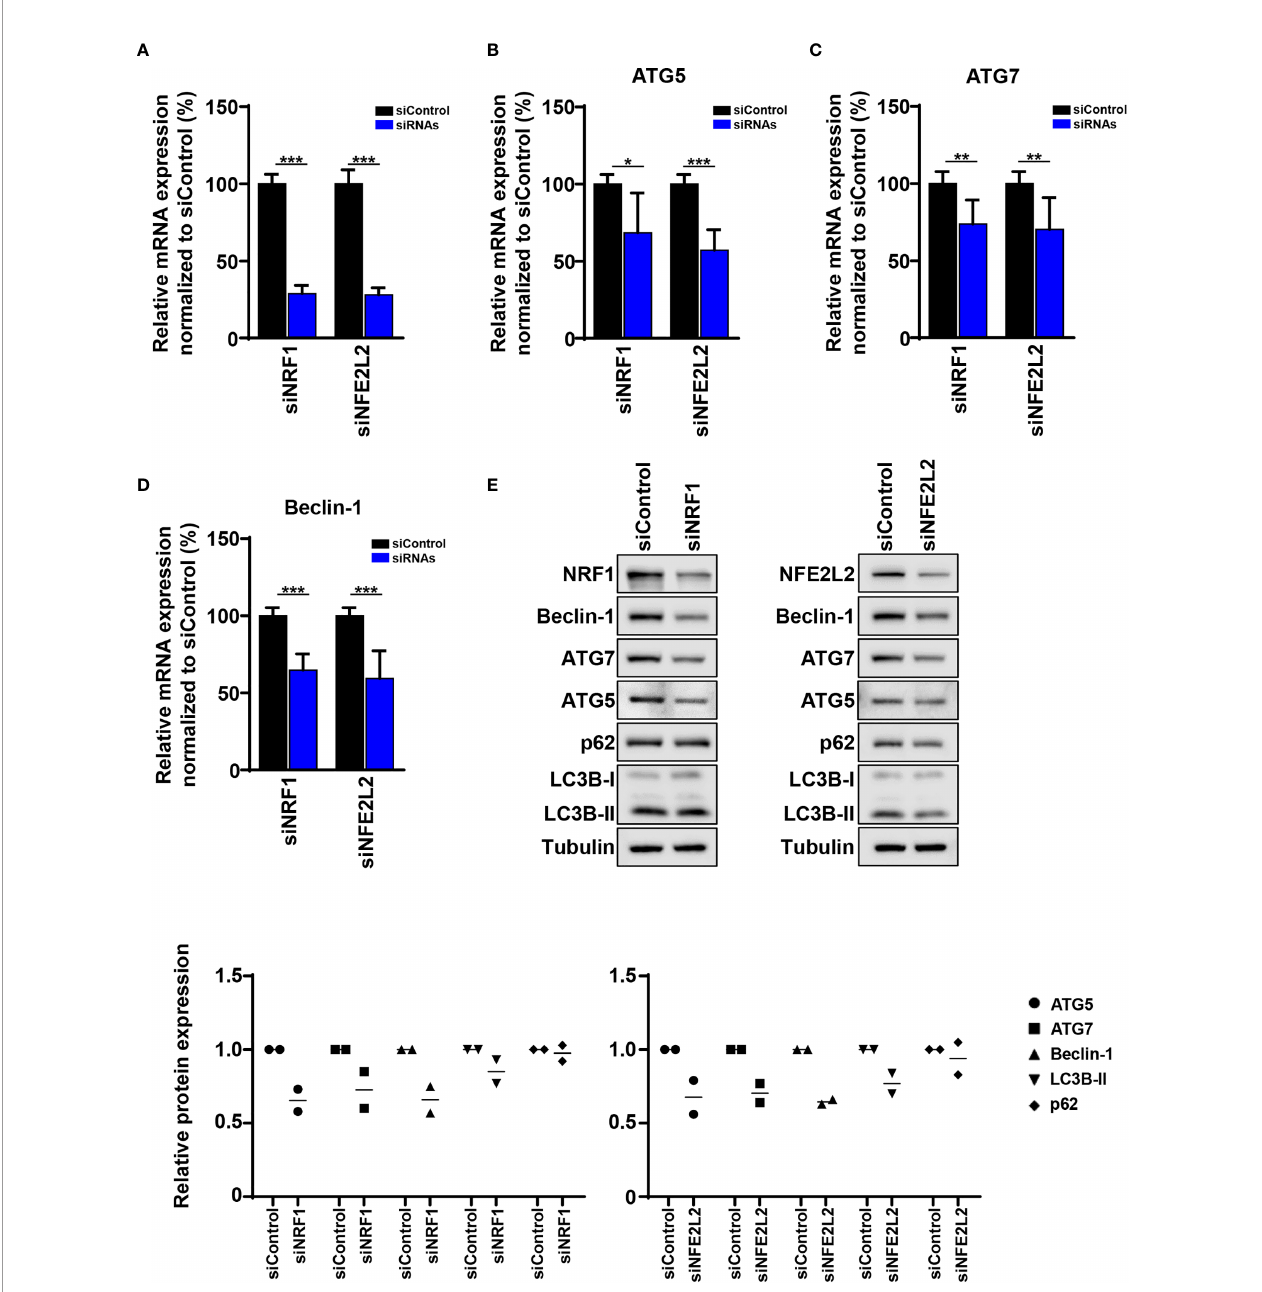
FIGURE 5 | The mRNA and protein levels of ATG5, ATG7, and Beclin-1 are in fl uenced by siRNA knockdown of NRF1 and NFE2L2 . (A) Quantitative polymerase chain reaction (qPCR). SK-MEL-5 melanoma cells were transfected with 50 nM siRNAs (Dharmacon) against NRF1 and NFE2L2 and Non-Targeting siRNA (Control). After 48 h NRF1 and NFE2L2 mRNA levels were determined by qPCR and normalized to HPRT mRNA levels. Statistical differences were analyzed by multiple t-test using the Holm-Sidak correction method (n=3). (B – D) Quantitative polymerase chain reaction (qPCR). SK-MEL-5 melanoma cells were transfected as described before and the mRNA levels of ATG5 , ATG7 and Beclin-1 were determined by qPCR and normalized to HPRT mRNA levels. Statistical differences were analyzed by multiple t-test using the Holm-Sidak correction method (n=3). p ≤ 0.05*; p ≤ 0.01**; p ≤ 0.001***. (E) Immunoblot. SK-MEL-5 melanoma cells were transfected as described before. Expression of ATG5, ATG7, Beclin-1, LC3B, p62, NRF1, NFE2L2, and tubulin in siNRF1, siNFE2L2, and siControl cells. Lower panels: Quanti fi cation of the immunoblots. Values were normalized to the housekeeping protein and to siControl